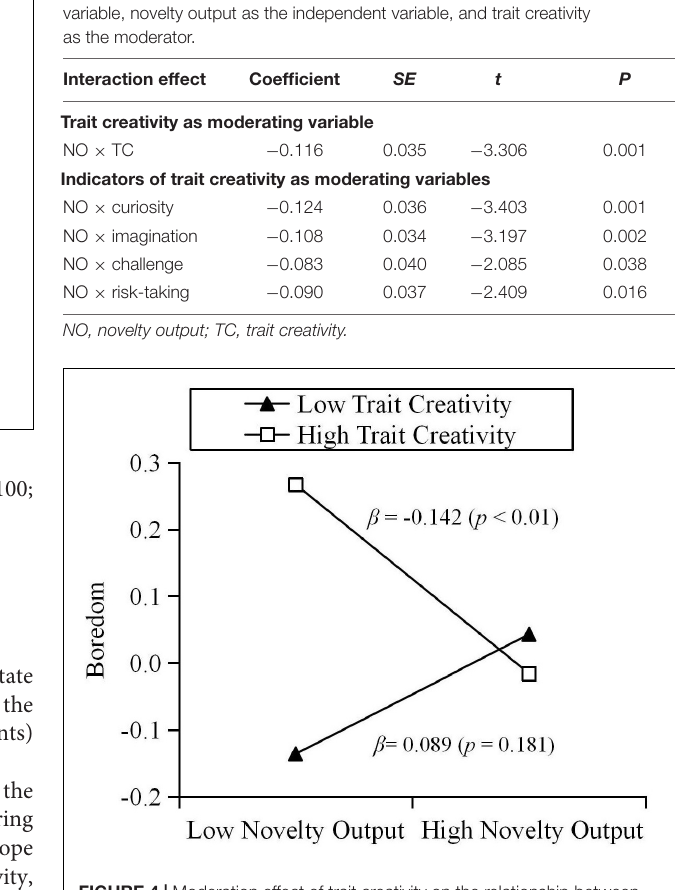
FIGURE 4 | Moderation effect of trait creativity on the relationship between novelty output and